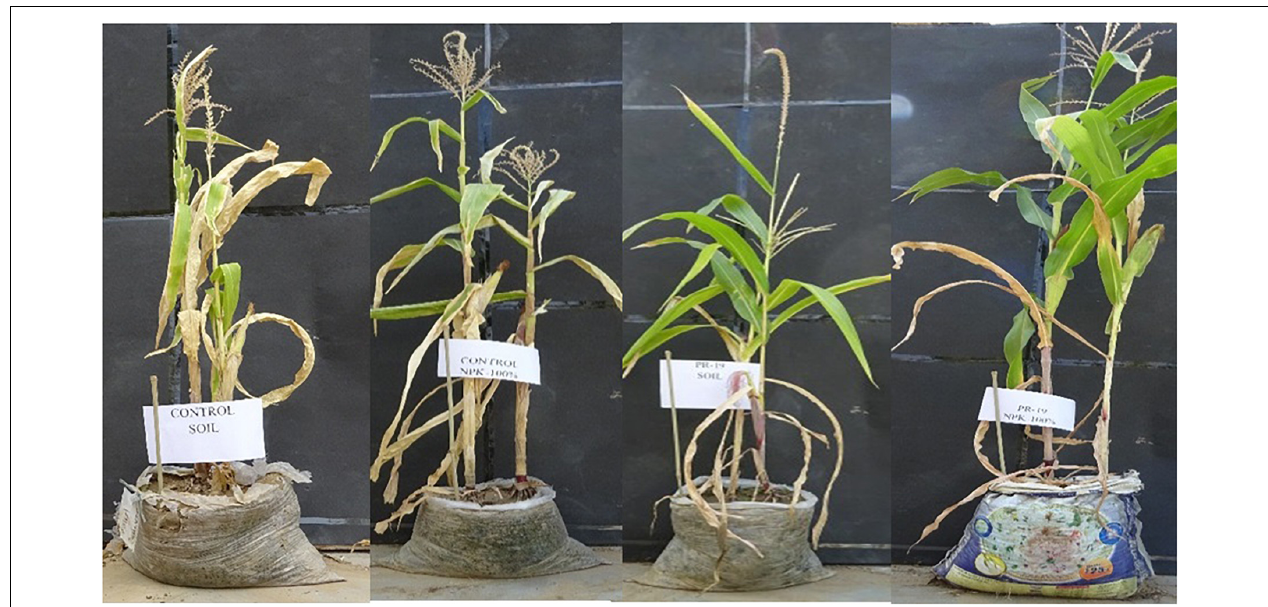
FIGURE 3 | Effect of PR19 on Maize Var. SHIATS MS-2 under pots/polybags condition. T0 = Control (no-fertilizer and no-bacteria inoculants), T1 = Std. NPK (120:60:40 kg/ha; 25%; no-bacteria inoculants only fertilizer), T2 = PR19 (only bacterial culture), T3 = PR19 (bacterial culture) and NPKs(120:60:40 kg/ha;